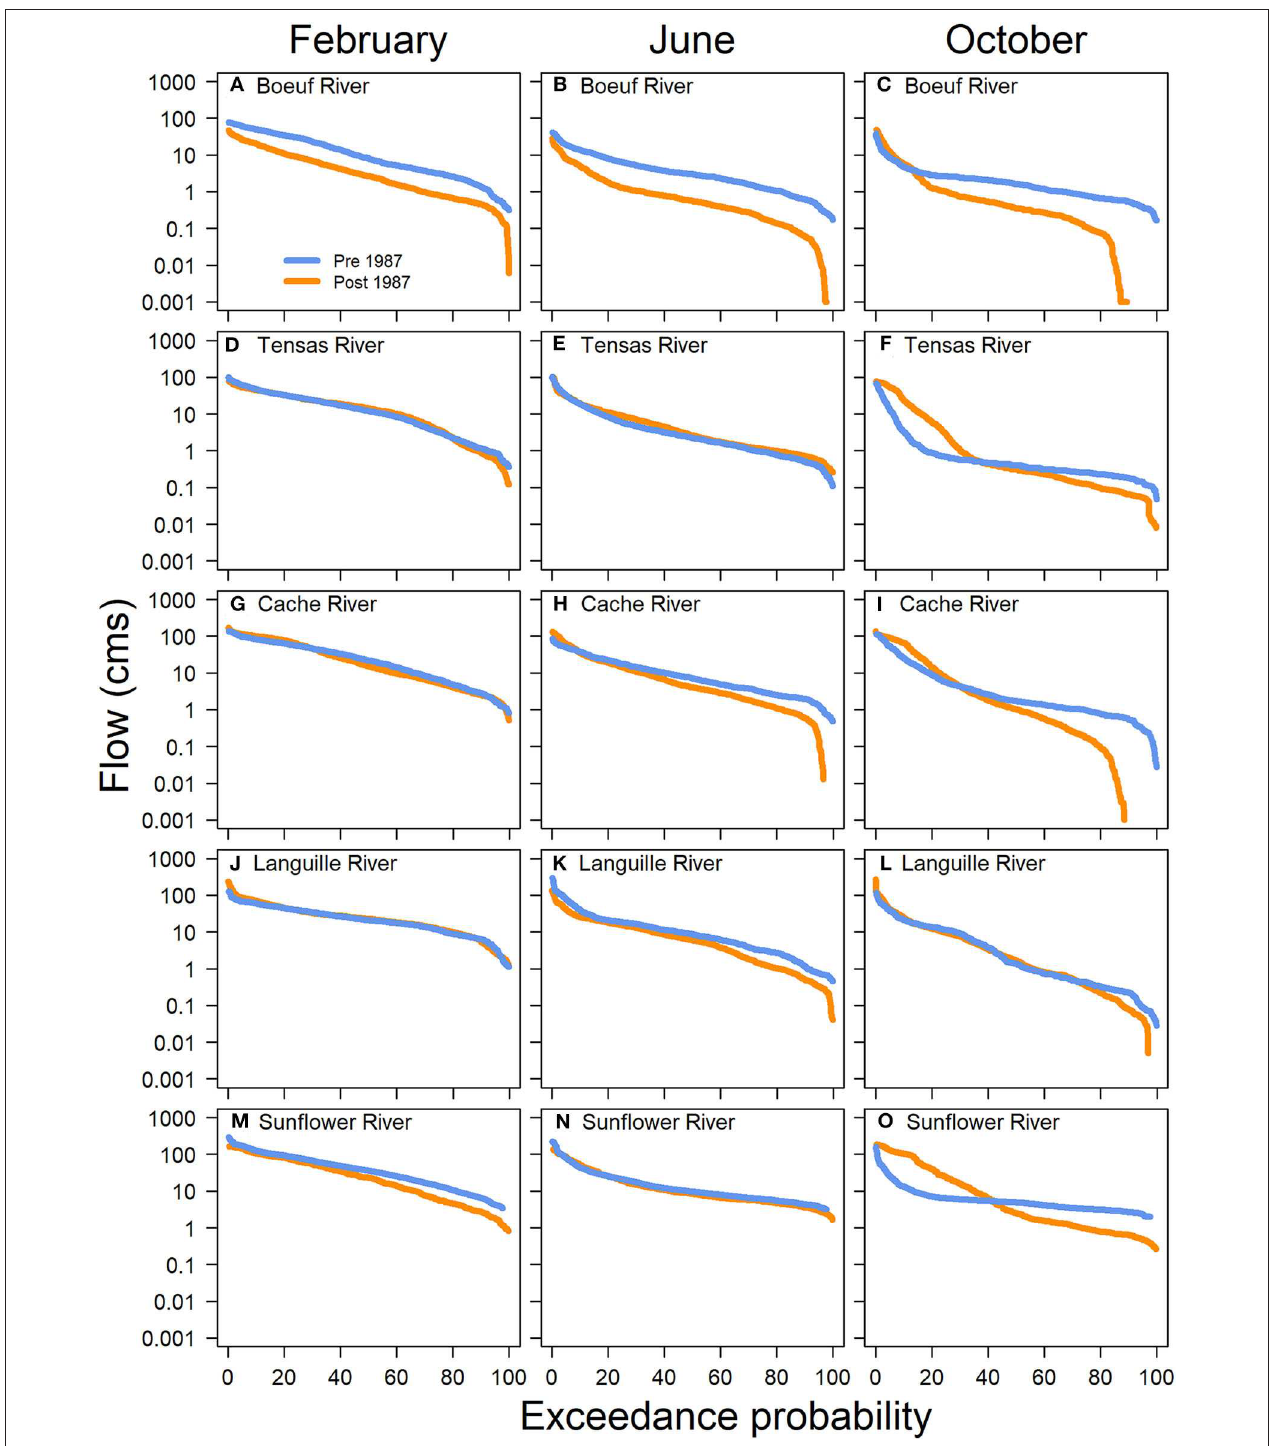
FIGURE 6 | Flow duration curves plotted as flow vs. exceedance probability for February, June, and October flow values for the (A–C) Boeuf River near Girard, (D–F) Tensas River near Tendal, (G–I) Cache River near Egypt, (J–L) Languille River at Colt, and (M–O) the Sunflower River at Sunflower gages. The blue lines represent flows before 1987 and the orange lines represent flow after